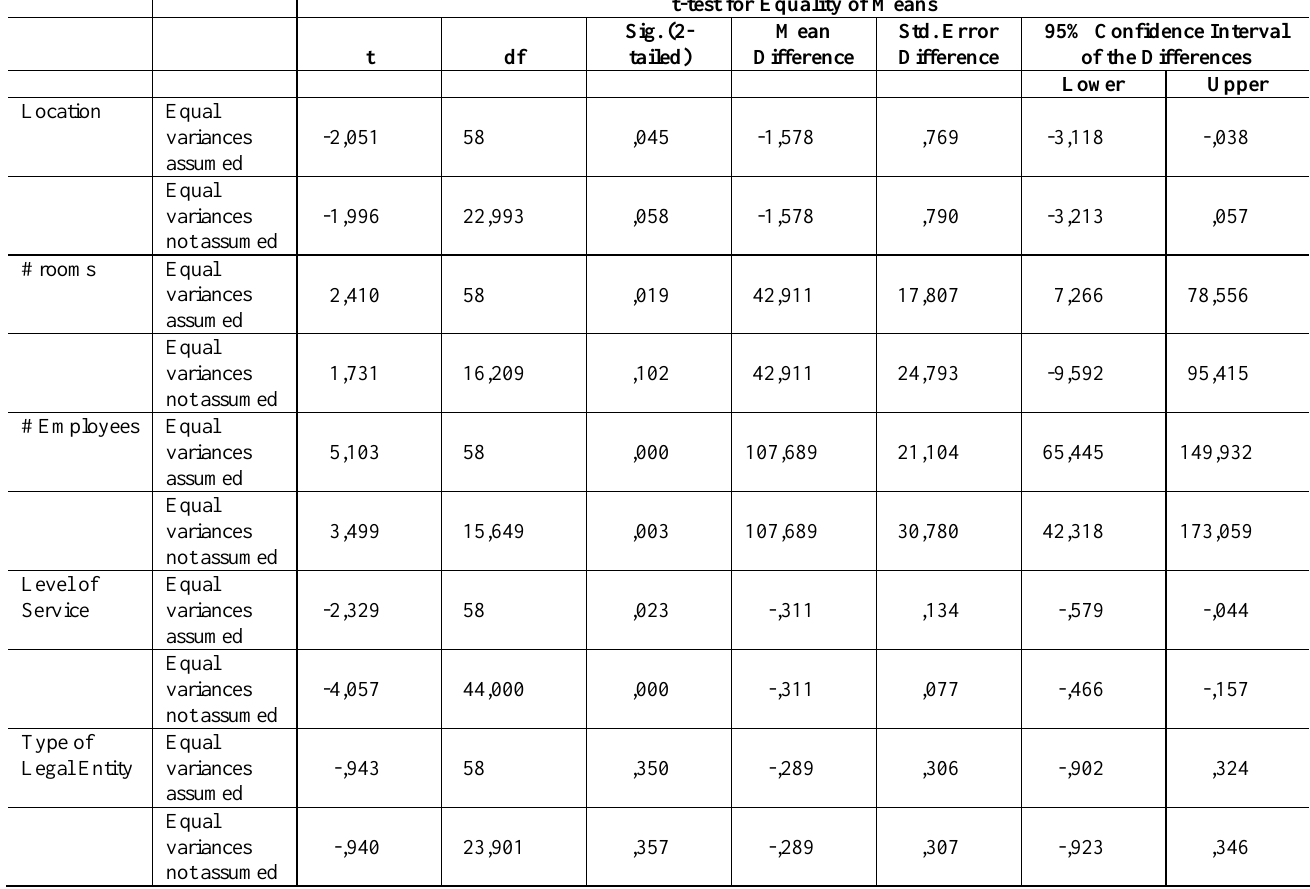
Table 2: Independent samples